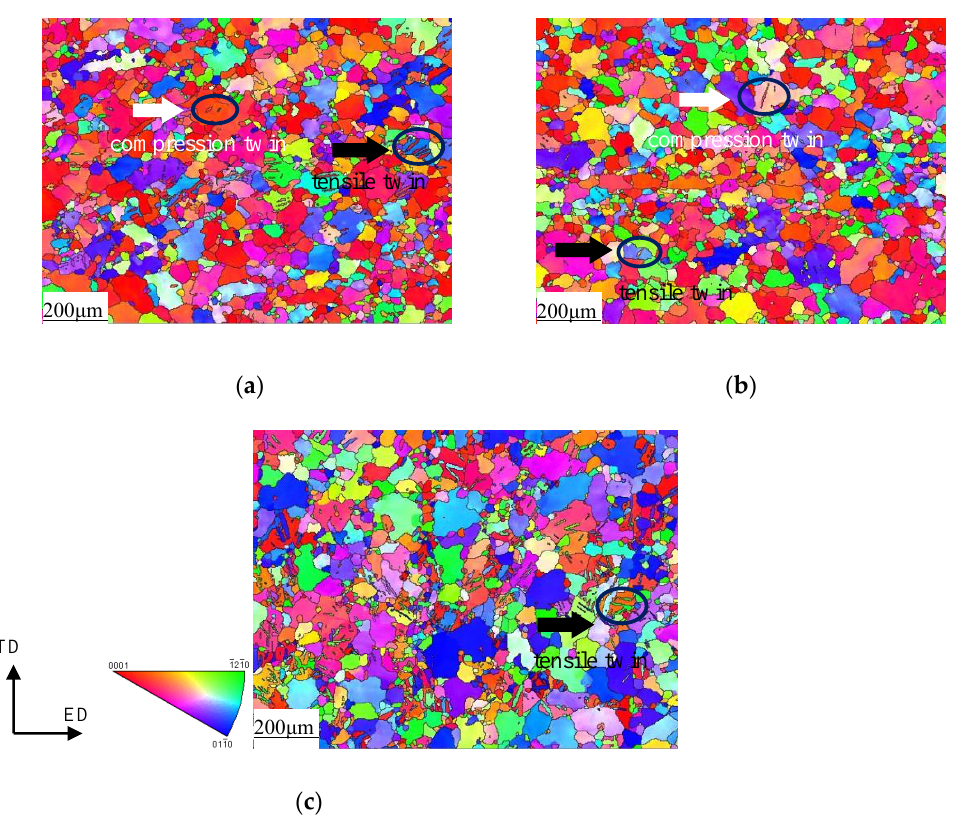
Figure 6. Grain orientation (IPF) of different samples under axial tension of 0.08: ( a ) T0 sample, ( b ) T45 sample, ( c ) T90 sample.